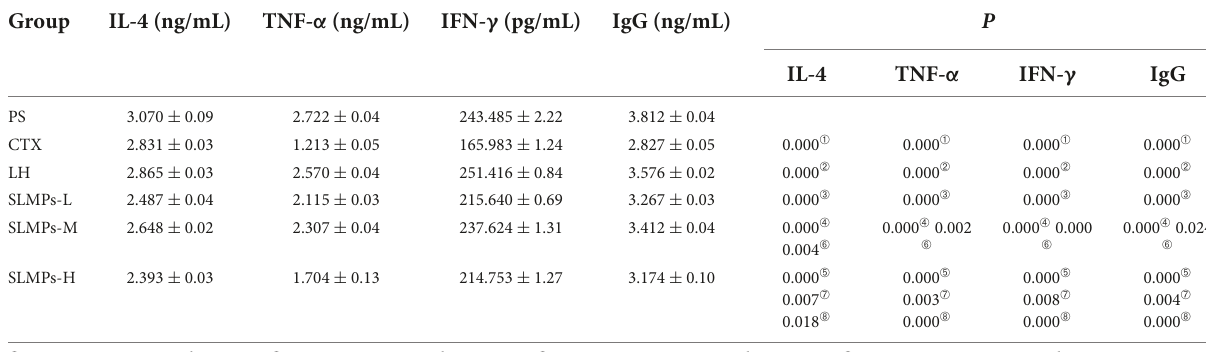
TABLE 3 Comparison of plasma levels of IL-4, TNF- α , IFN- γ , and IgG in each group of mice. Group